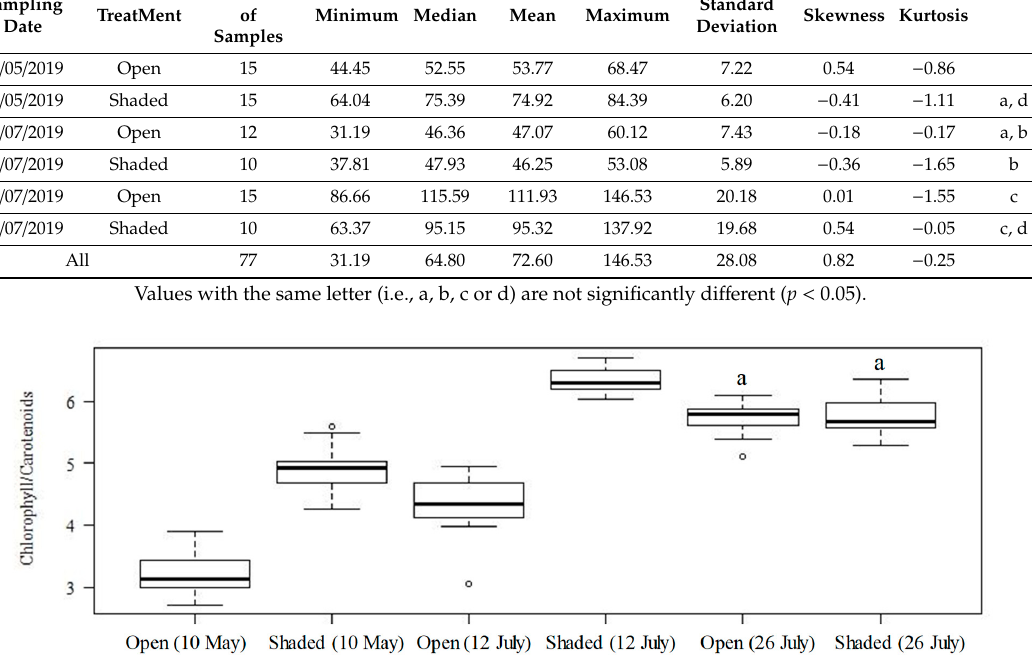
Figure 1. Boxplots of the ratio of total chlorophyll to carotenoids. Values with the same letter (i.e., a) are not significantly different ( p < 0.05).